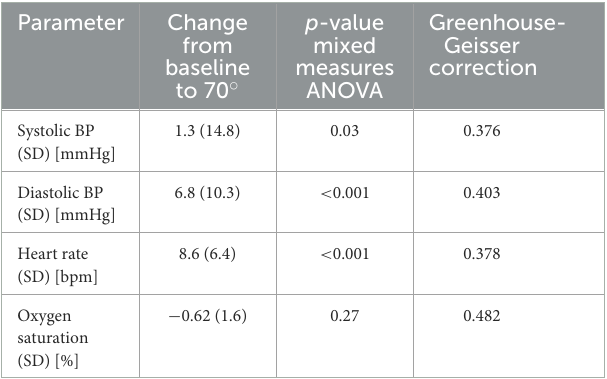
TABLE 4 Changes of systolic and diastolic blood pressure (BP), heart rate and oxygen